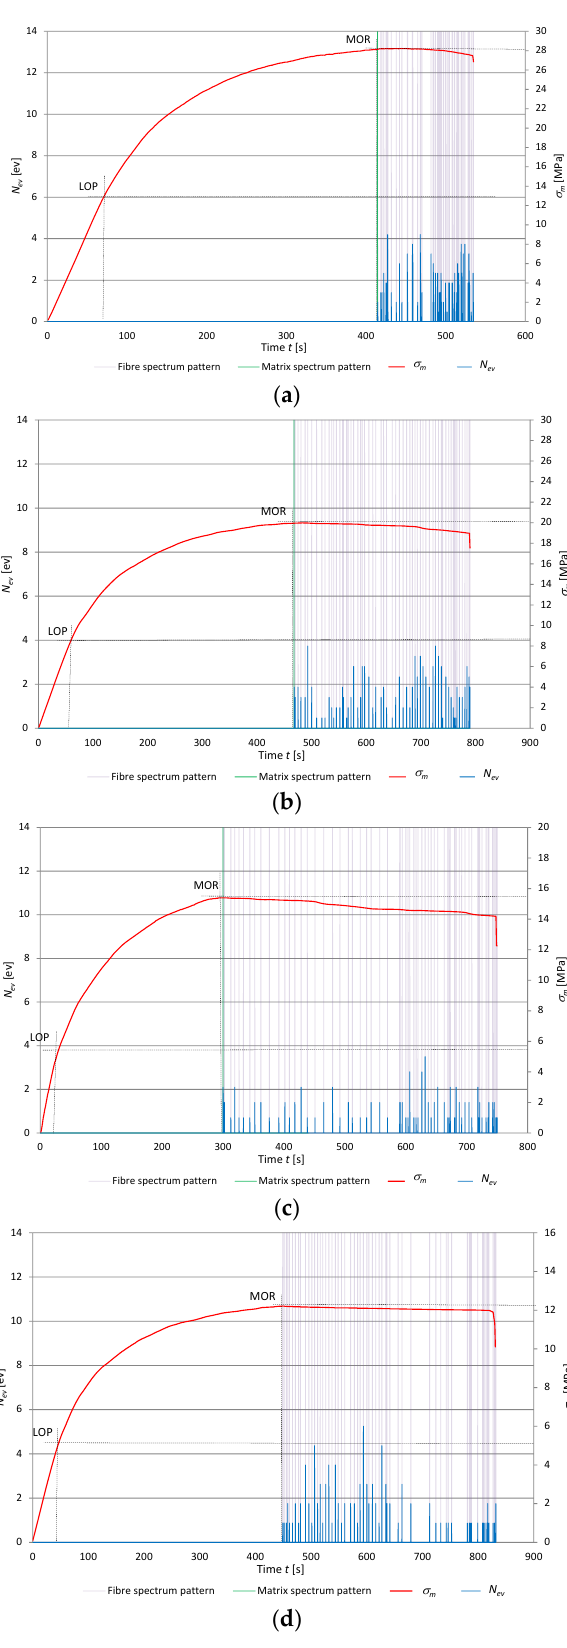
Figure 9. Events rate N ev and flexural stress σ m versus time for fiber cement boards stored in water for 1 h, with marked reference spectral patterns: ( a ) series A, ( b ) series B, ( c ) series C, ( d ) series D.